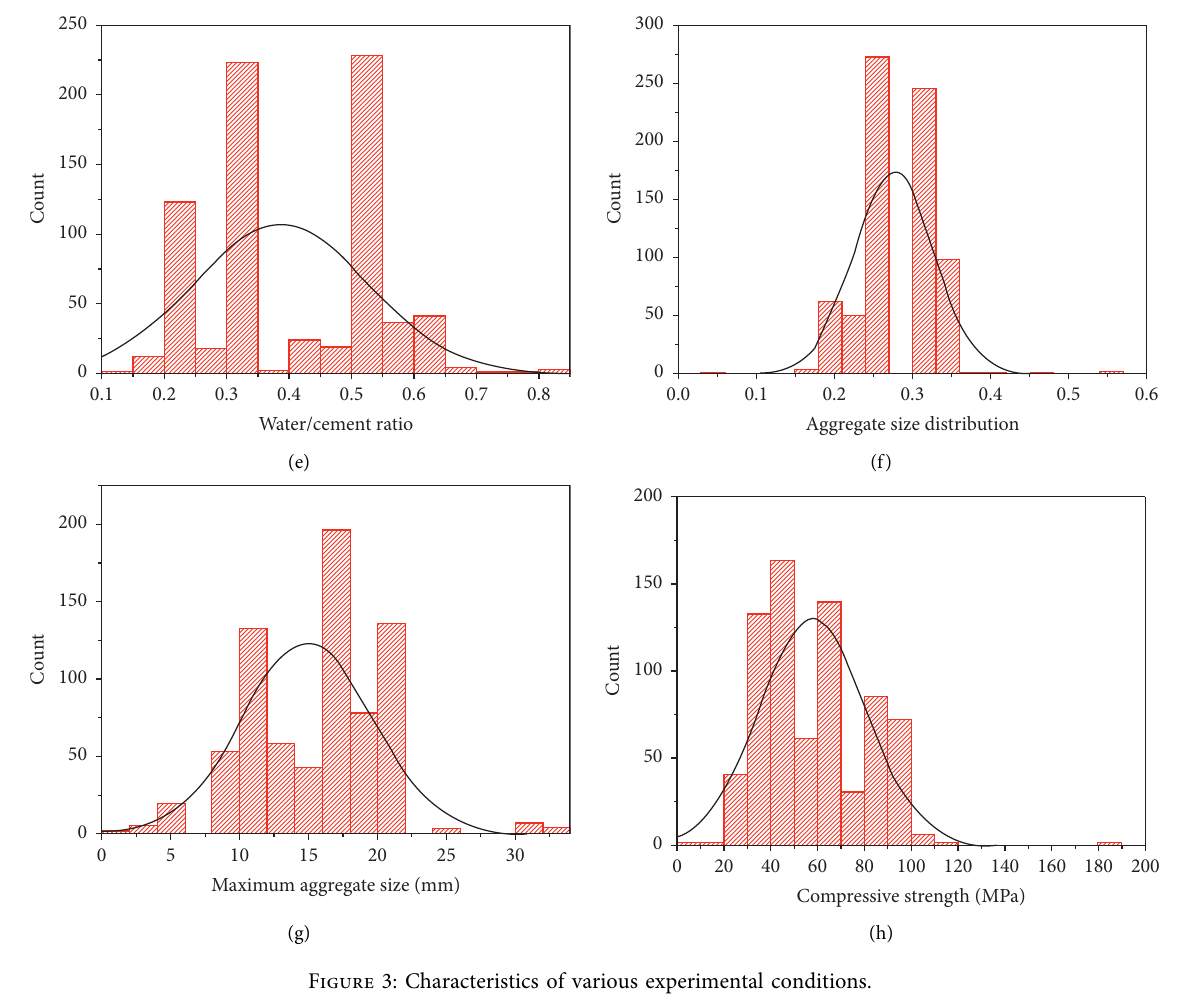
Figure 3: Characteristics of various experimental conditions.